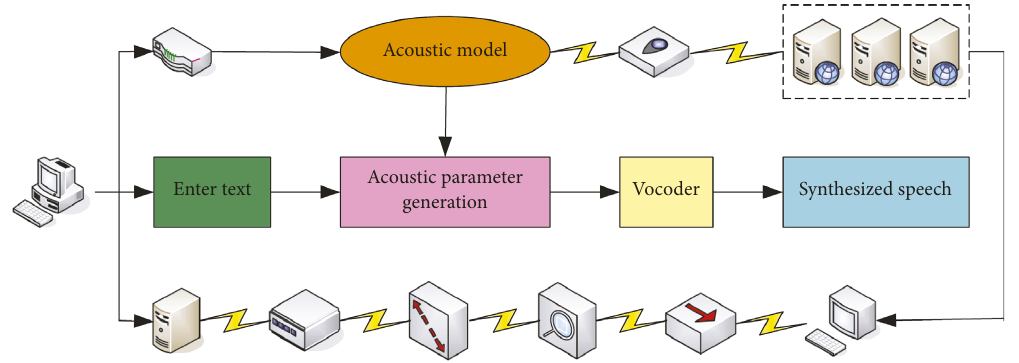
Figure 1: Traditional TTS system.